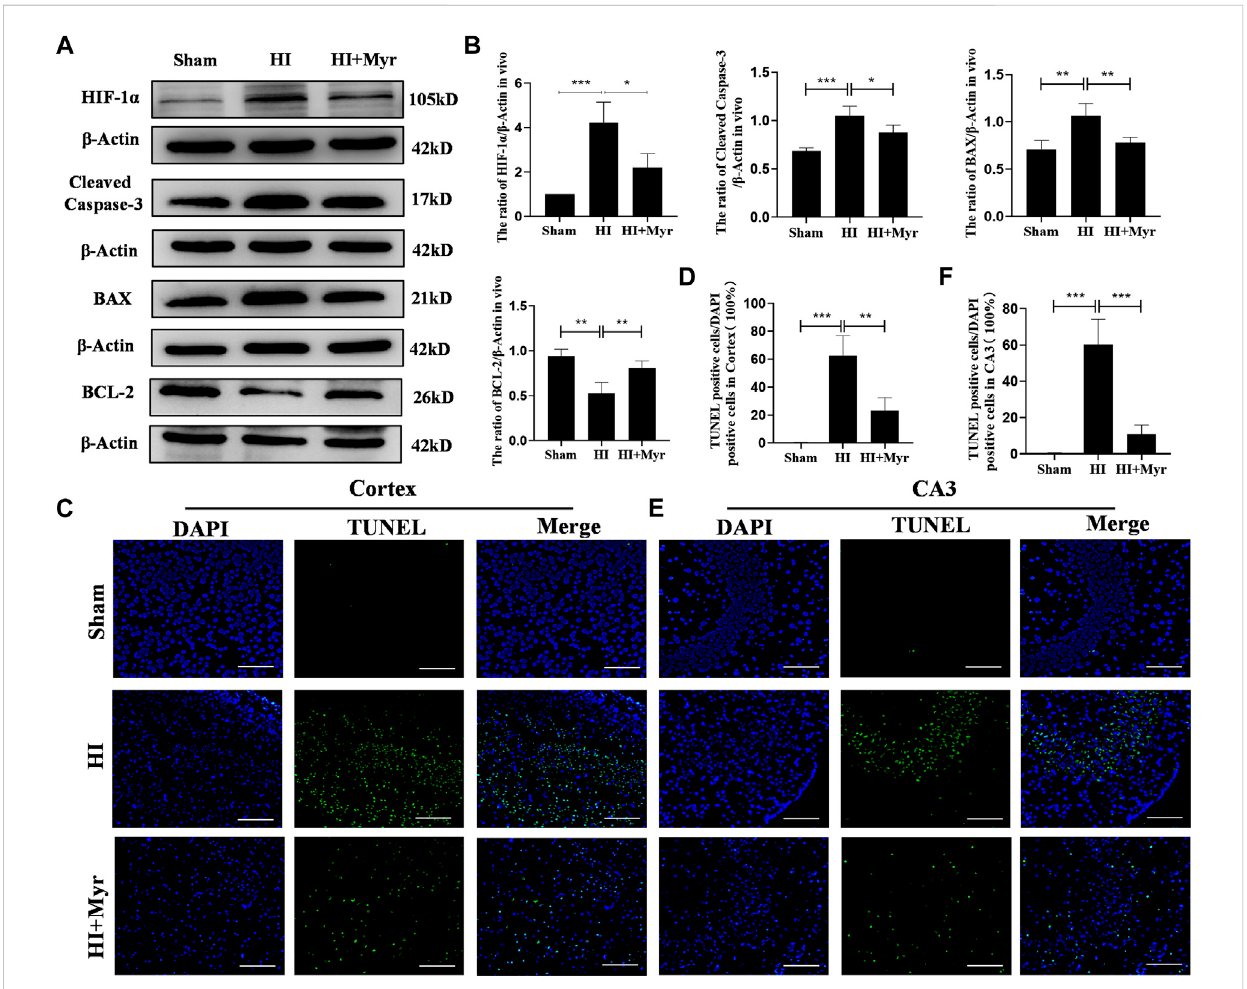
FIGURE 4 Myricetin reduced apoptosis induced by hypoxic-ischemic brain injury. (A) The protein bands of HIF-1 α , Cleaved Caspase-3, BAX, and BCL-2 were detected by Western blot 24 h after HI brain injury. (B) Quantitative analysis of Western blot bands ( n = 4 per group). (C) The representative images of TUNEL staining inbrain cortex 24 hafter HI braininjury.Nucleuswerestained with DAPI (blue). (D) Quantitative analysis of TUNEL staining inbrain cortex ( n = 4 per group). (E) The representative images of TUNEL staining in hippocampal CA3 region 24 h after HI brain injury. (F) Quantitative analysis of TUNELstaininginhippocampalCA3region( n =4pergroup).Thedataarepresentedasmean±SD.* p < 0.05,** p < 0.01,*** p < 0.001.Scalebar:100 μ